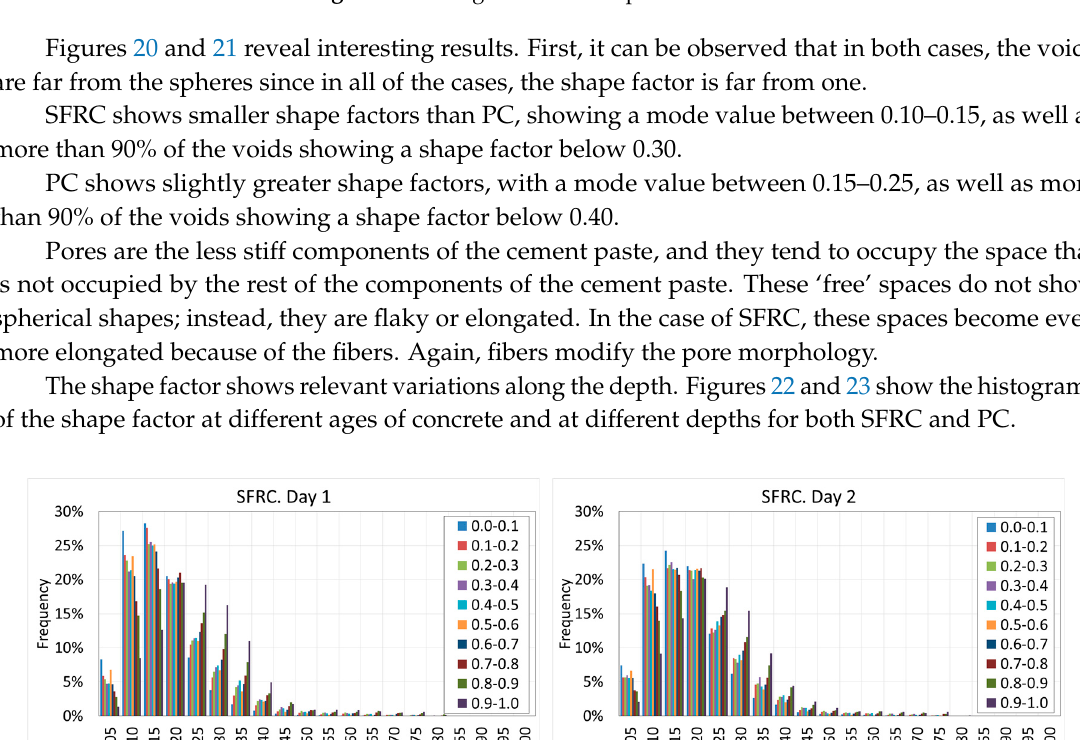
Figure 21. Histogram of the shape factor of PC.